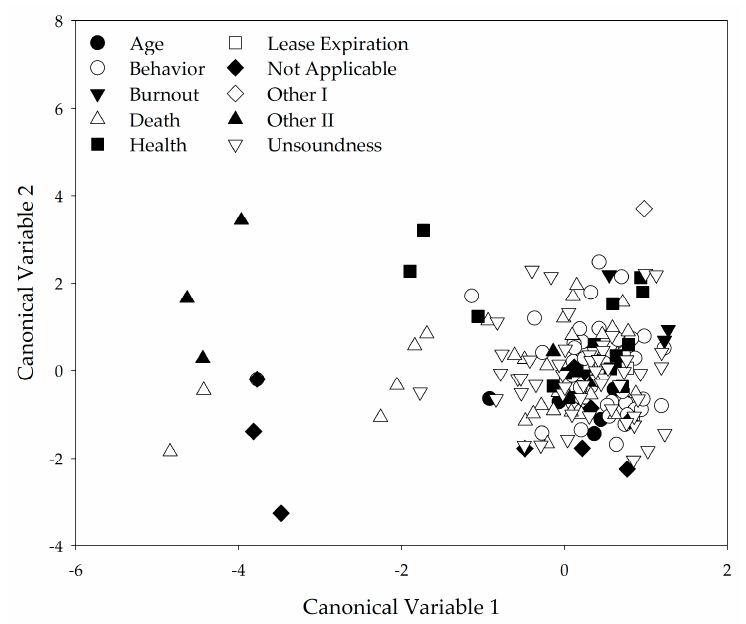
Figure 10. Plot of canonical variables 1 and 2 derived from the canonical discriminant analysis. Little grouping by classification variable is observed.